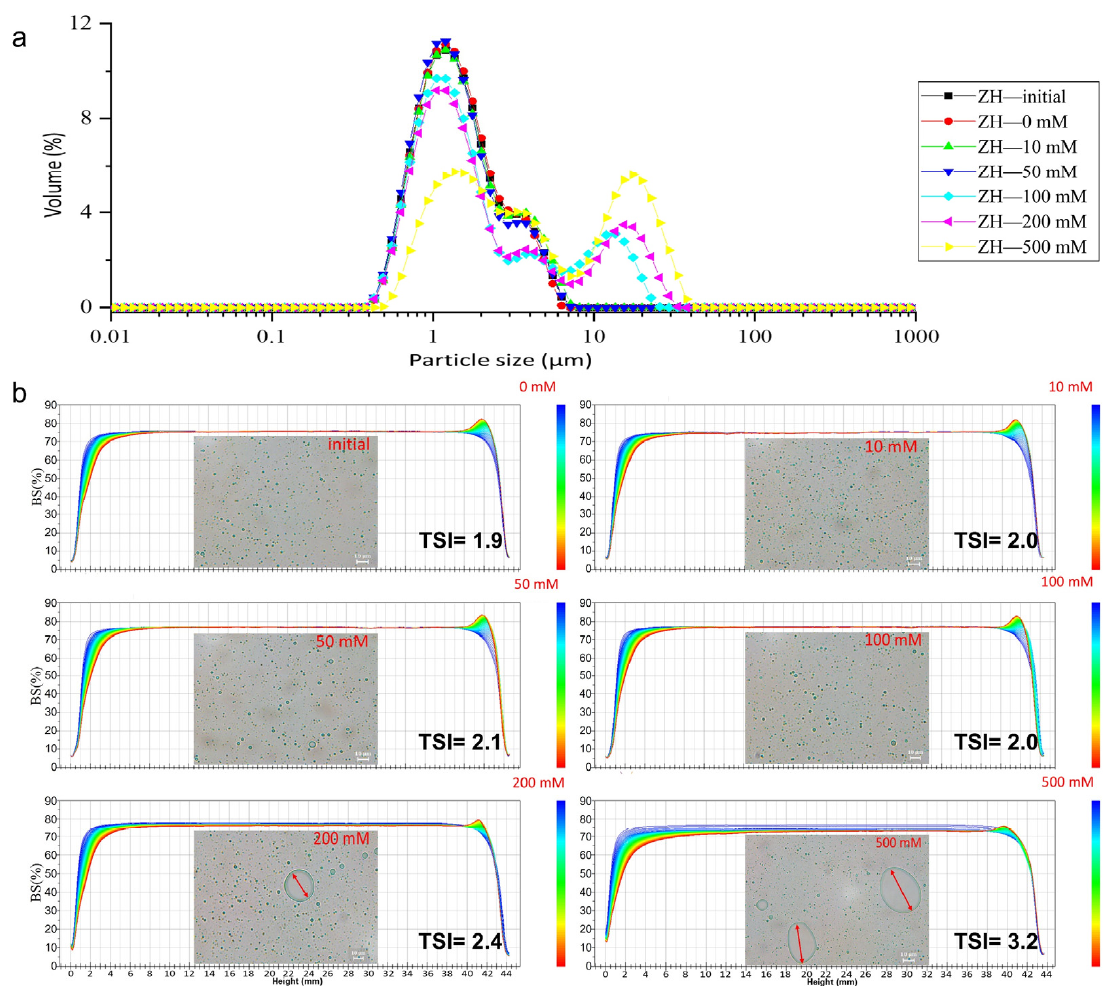
Figure 3. Particle size distribution of emulsions stabilized by ZH 0.6-70 after adding different concentrations of NaCl ( a ); Back-scattered light map and microscopic images (scale bar =10 µm) of emulsions stabilized by ZH 0.6–70 after adding different concentrations of NaCl ( b ).